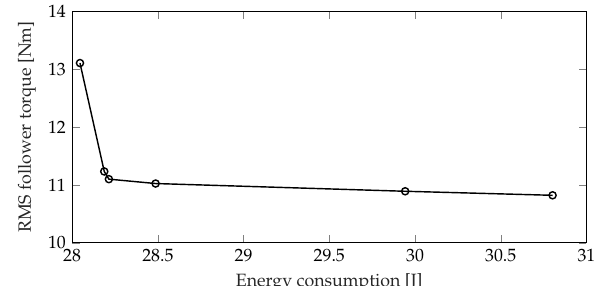
Figure 10. Pareto front for the multi-objective OCP.